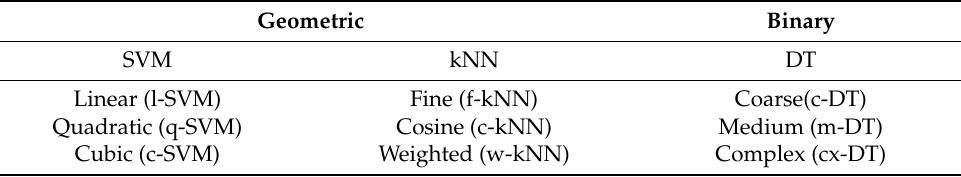
Table 3. List of tested machine-learning algorithms and